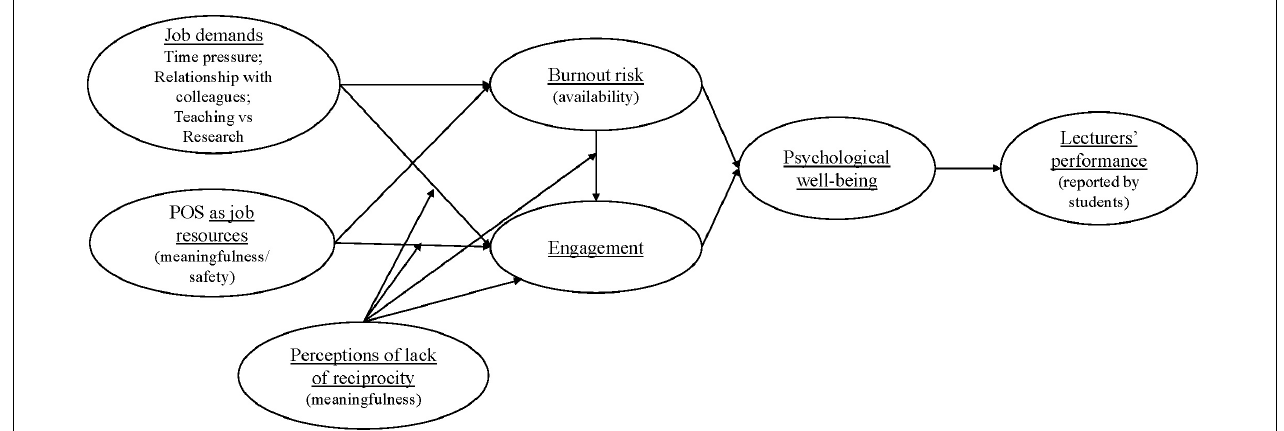
FIGURE 1 | Conceptual framework (measurement